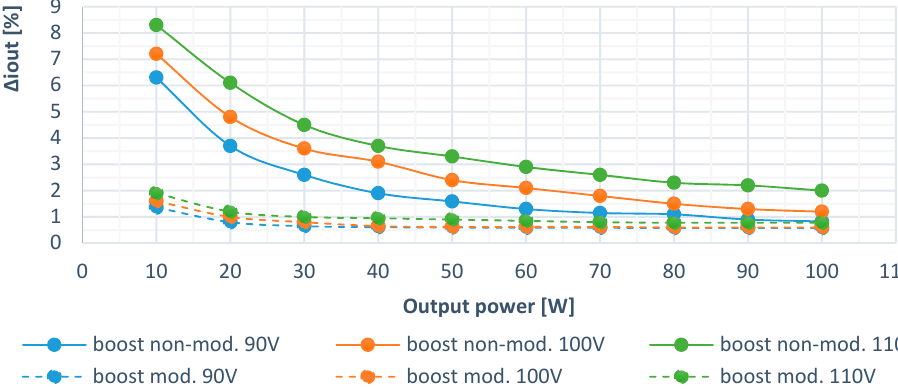
Figure 16. The dependency of output current ripple on output power and input voltage for proposed bi-BB converters for boost mode.